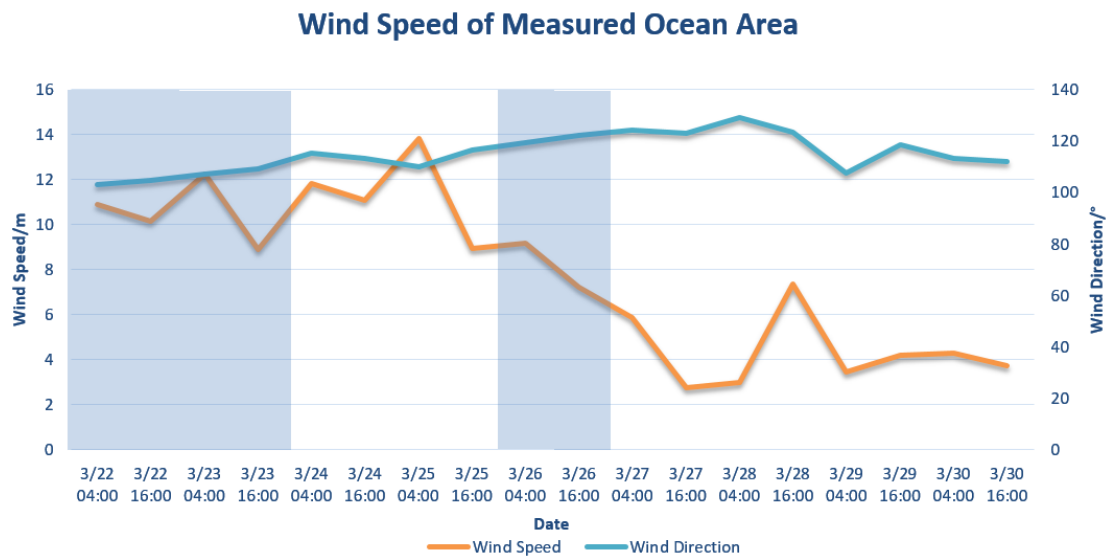
Figure 11. Wind velocity and direction during March 22 and March 30. The blue shade indicates the occurrence of rain.